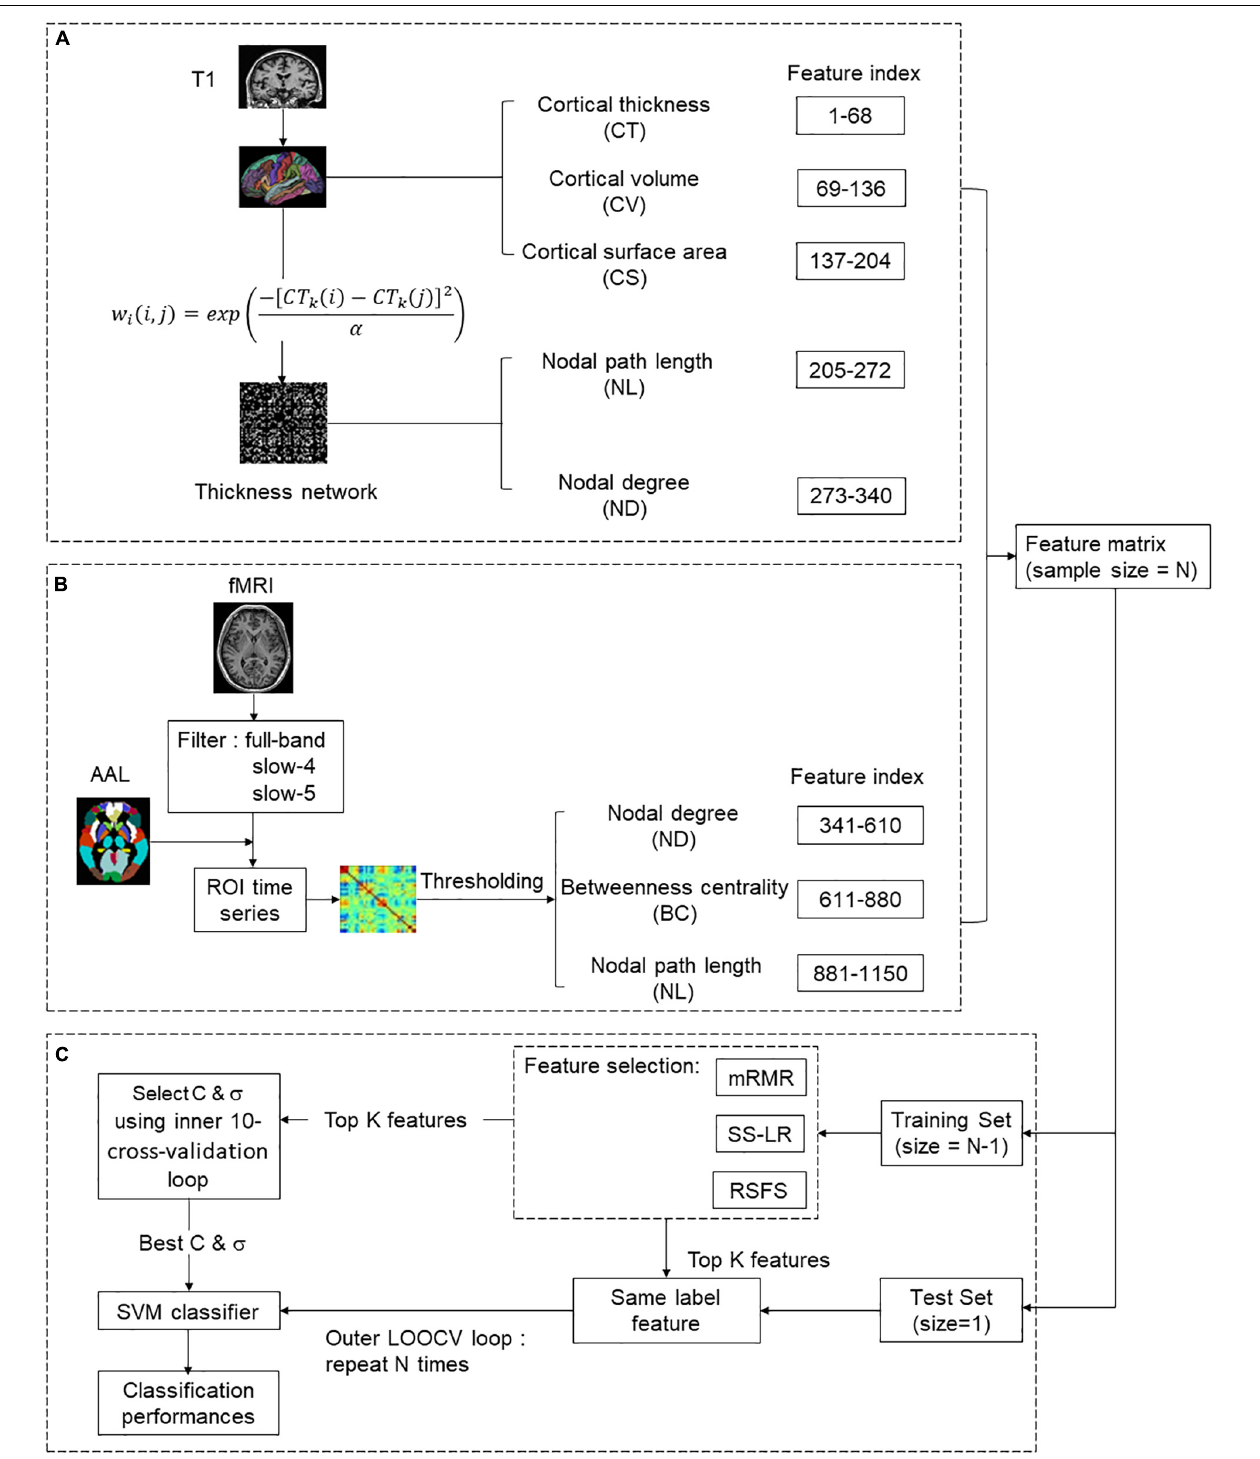
FIGURE 1 | The overall classification framework for predicting the conversion of MCI. (A) Structural feature extraction: preprocessing T1 data, extract MRI features and thickness network features. (B) Functional feature extraction: preprocessing rs-fMRI data, constructing resting-state functional brain network and extracting features. (C) Feature selection and